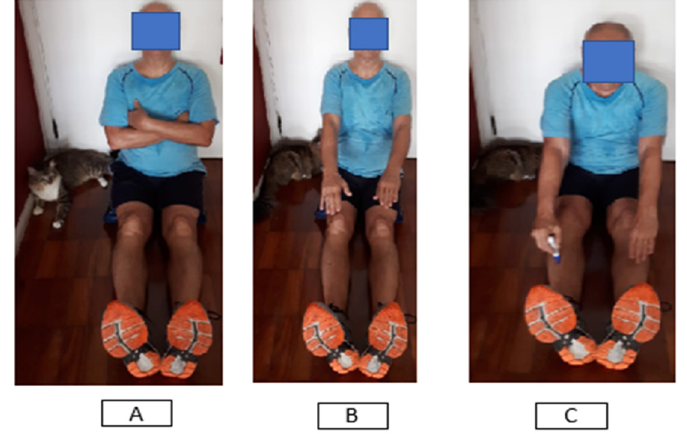
Figure 10. Steps of the sit-and-reach exercise. The individual ( A ) is sitting on the floor with the back in contact with the wall, ( B ) the arm stretched, and ( C ) reaches forward slowly, as far as possible, with their hands overlapped and to hold the end position and a mark with a pen is done in the